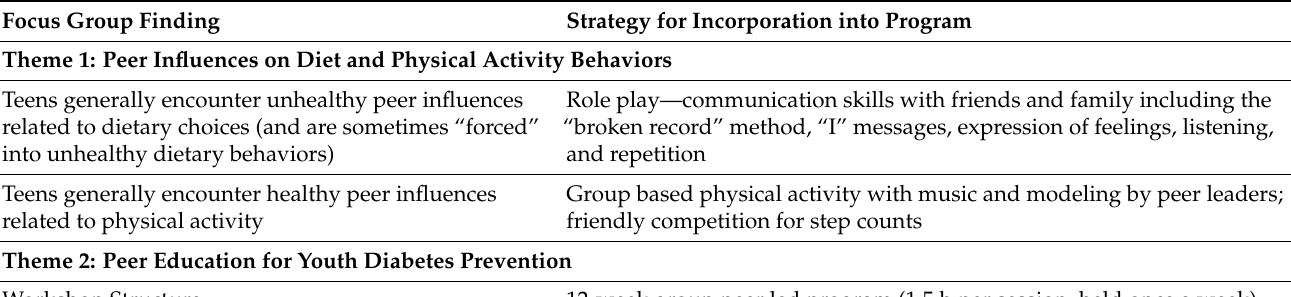
Table 4. Translation of Focus Group Findings into Components of Youth Diabetes Prevention Program. Focus Group